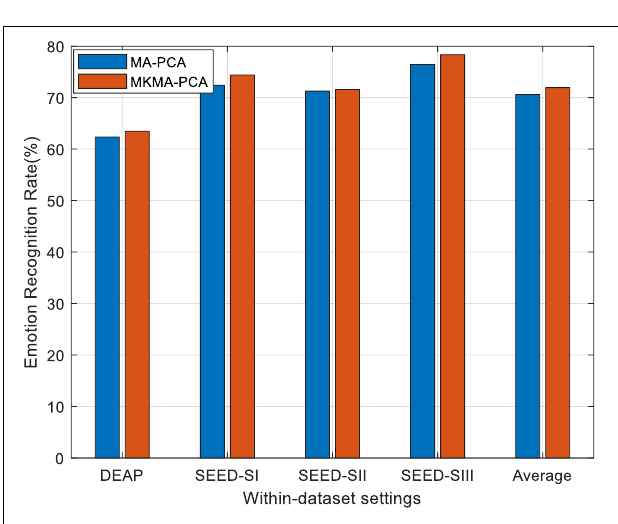
FIGURE 2 | Emotion recognition on within-dataset with multiple kernel learning. SI, session I; SII, session II; SIII, session III (similarly